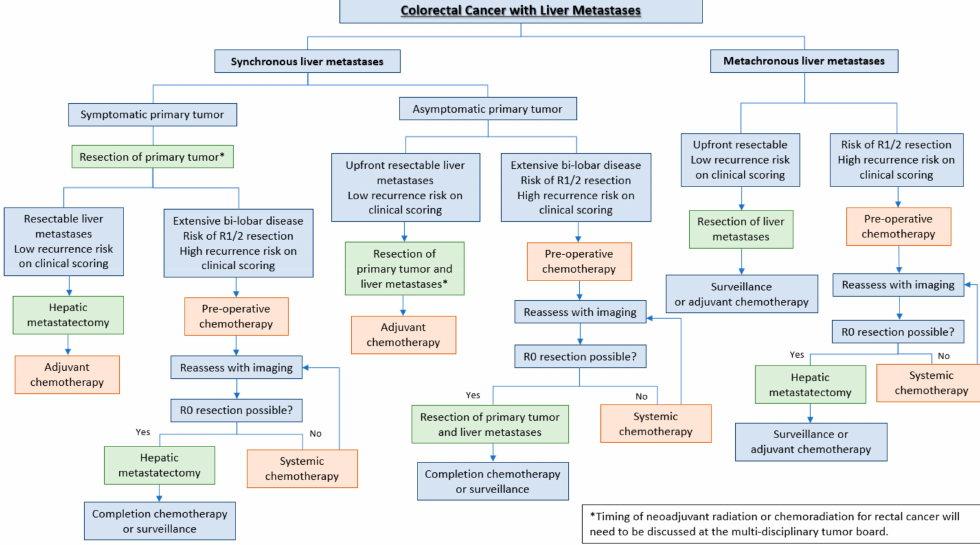
Figure 1. Decision tree for timing and sequence of systemic therapy and surgery for patients with metastatic colorectal cancer to the